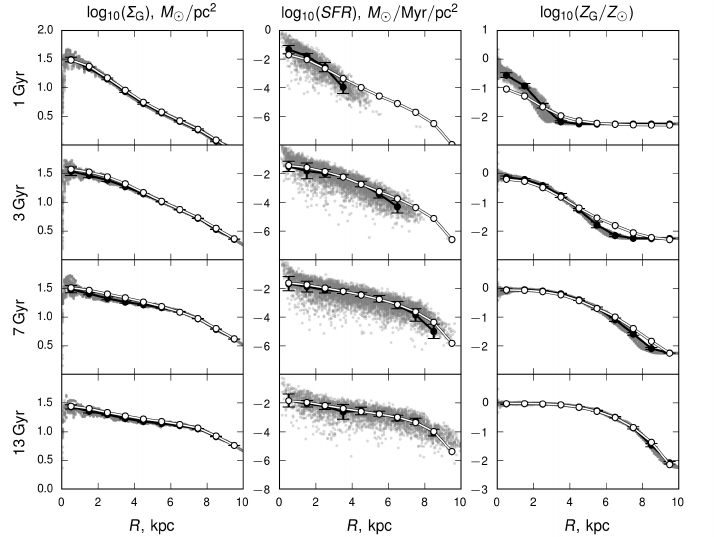
Fig. 6. The same as in Fig. 5, but for the HS